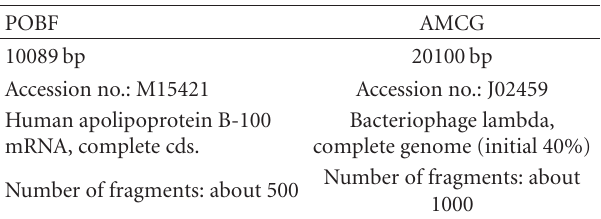
Table 1: Experimental genome data.